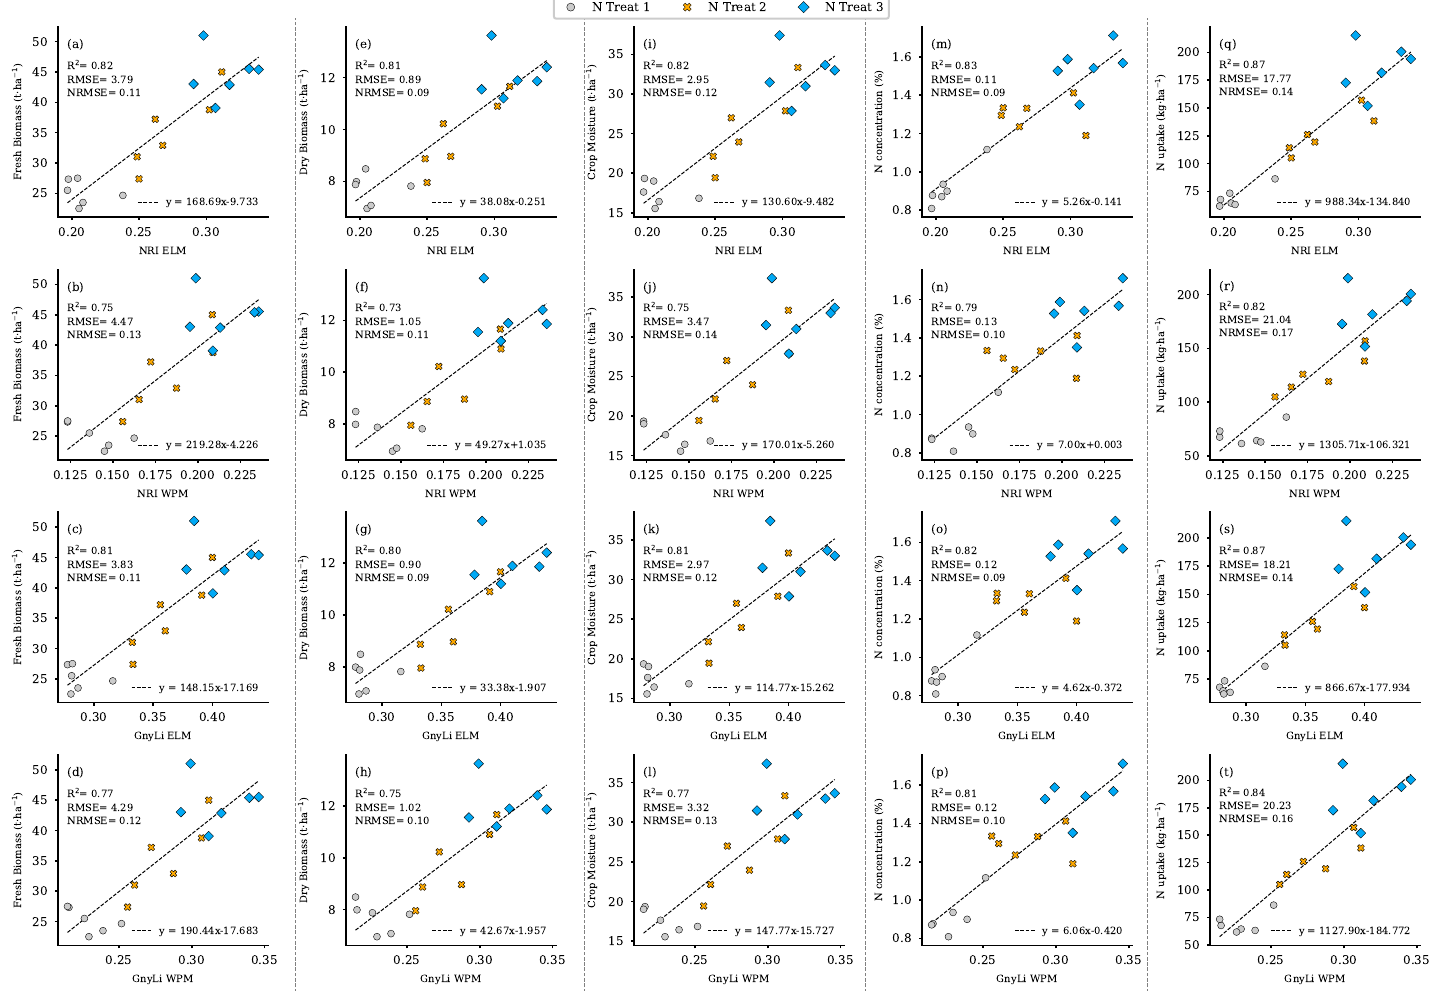
Figure 19. Scatter plots for the VI data for 2 June as estimators for the individual crop traits linearly interpolated from 26 May and 12 June of the 18 destructive sampling plots. ( a – d ) camSWIR VIs and FBM, ( e – h ) camSWIR VIs and DBM, ( i – l ) camSWIR VIs and crop moisture, ( m – p ) camSWIR VIs and N C , ( q – t ) camSWIR VIs and N uptake. ( p < 0.001 for all regression